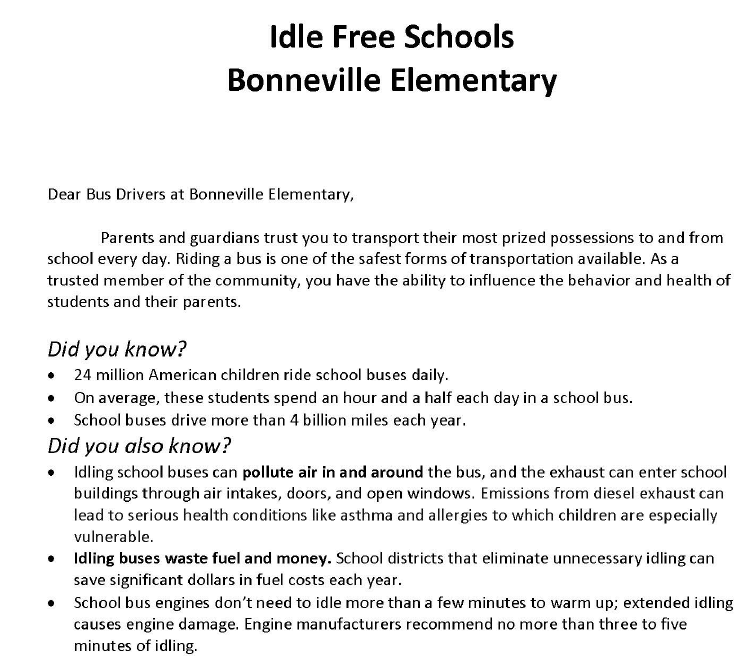
Figure A11. Idle-free schools pledge form for delivery truck drivers.